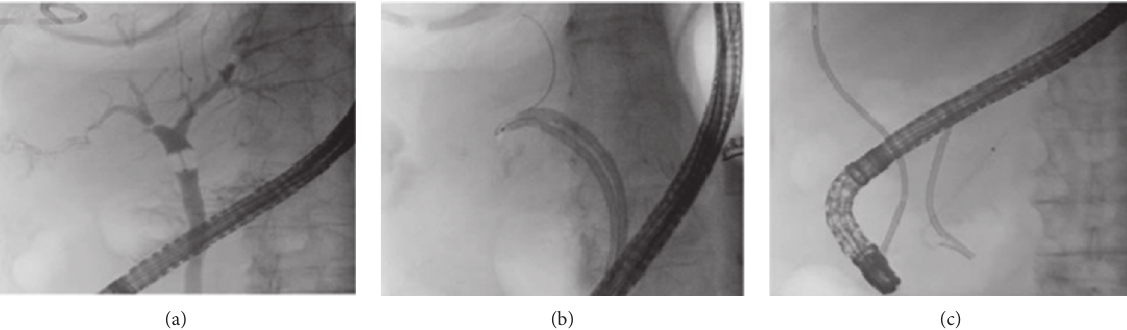
Figure 3: Endoscopic treatment of the BPF by means of a large sphincterotomy (a), placement of two biliary stents (AdvanixBiliary stent, Boston Scientific ® 10 Fr x 12 cm) to decompress the right bile duct (b), and a bilioduodenal endoprosthesis (c).